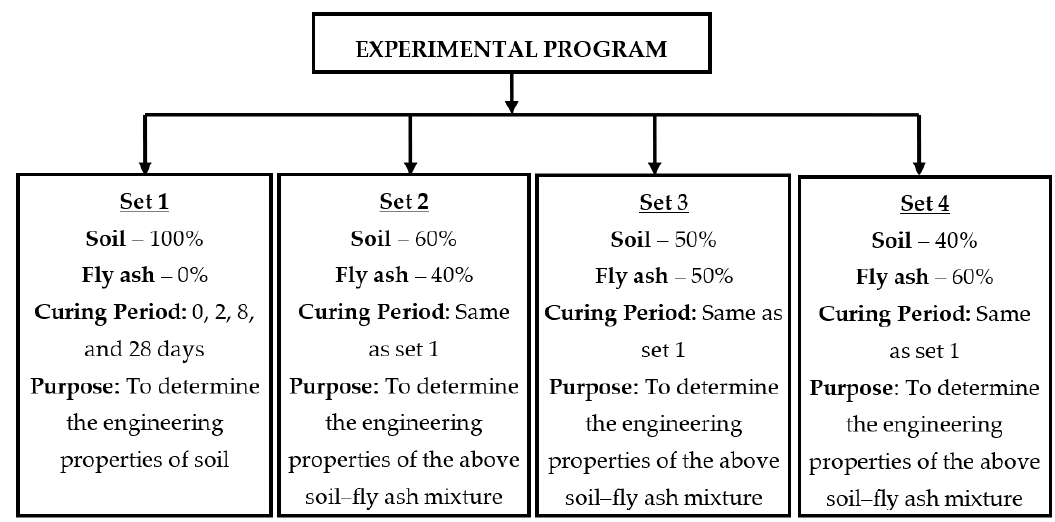
Figure 2. Flowchart for the experimental program.